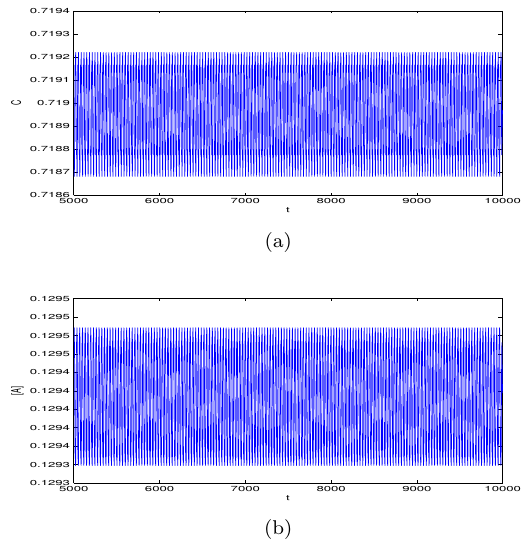
Figure 2. Simulation solution of (1.1): a periodic solution is bifurcated, when τ = 9 . 5 > τ 0 .